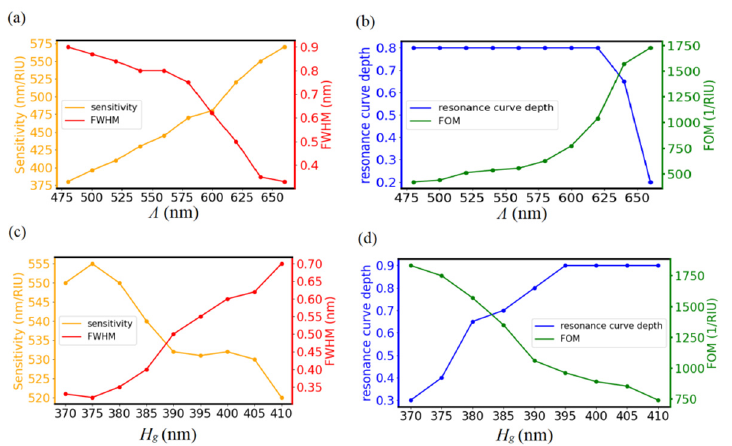
Figure 4. ( a ) Dependence of sensitivity and FWHM ( b ) resonance curve depth and FOM on Λ with H g at 380 nm, H m t at 100 nm, f at 0.25, and f i at 0.2. ( c ) Dependence of sensitivity and FWHM ( d ) resonance curve depth and FOM on H g with Λ at 640 nm, H m at 100 nm, f at 0.25, and f i at 0.2.